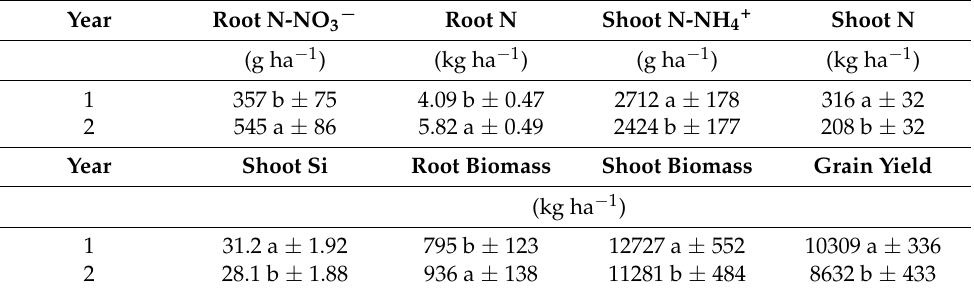
Table 3. Maize root nitrate (N-NO 3 − ); root N accumulation; shoot ammonium (N-NH 4+ ); shoot N; shoot Si accumulation; root biomass; shoot biomass and grain yield as a function of years of